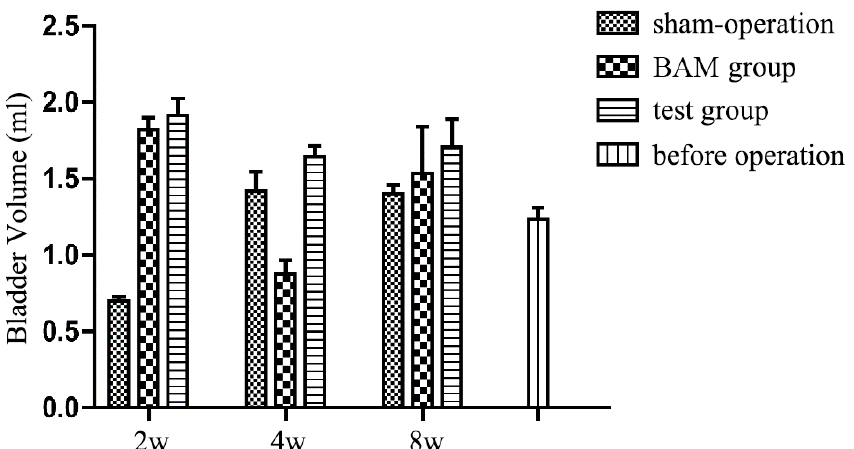
Figure 6. Quantity comparison of maximal bladder capacity in different groups at 2nd, 4th, 8th week after surgery. Maximum capacity was recorded when leakage first occurs.